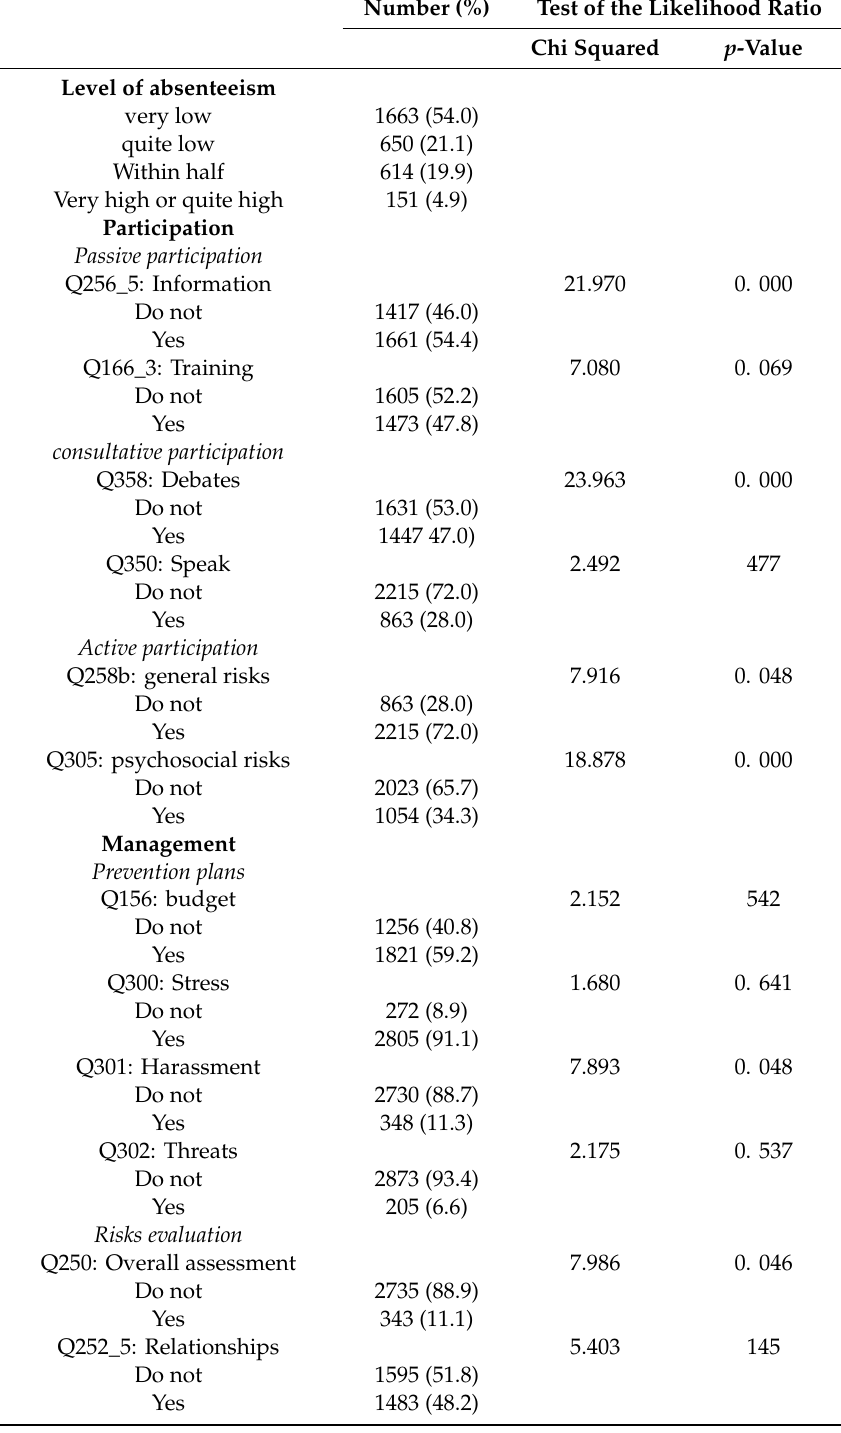
Table A1. Descriptive analysis of the multinomial logistic